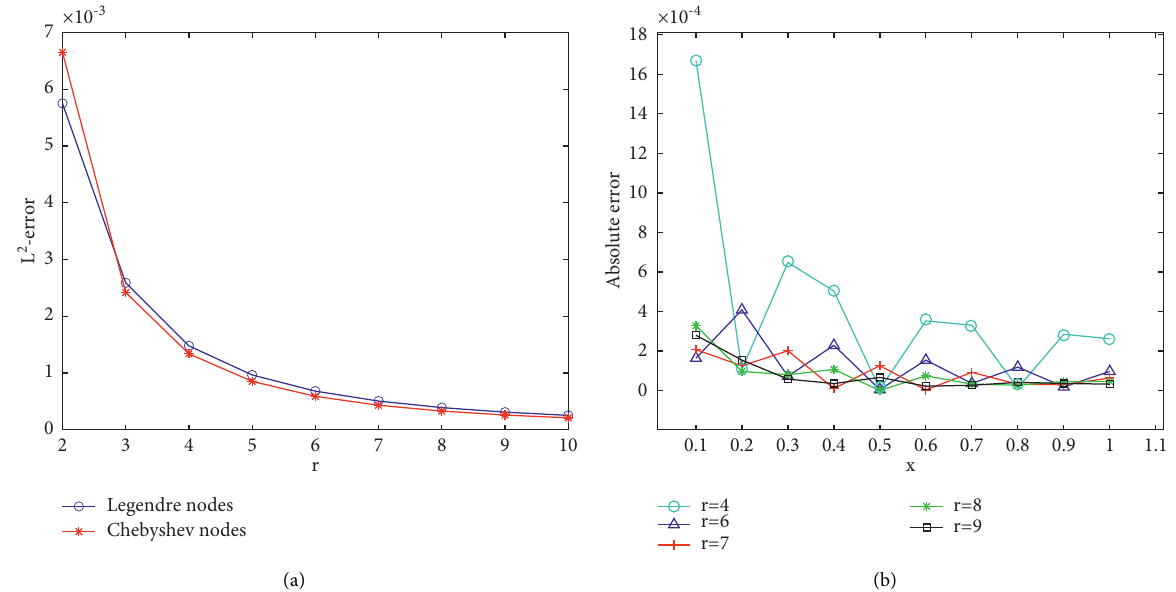
Figure 2: Plot of the L 2 -errors (a) taking the Legendre and Chebyshev nodes and the absolute error at the Chebyshev nodes (b) for Example 1.